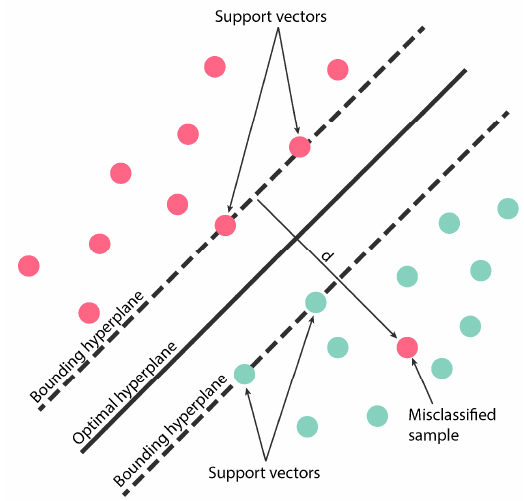
Figure 2. The support vector machines (SVM) method: the optimal hyperplane separates the two classes and is parallel to the bounding hyperplanes on which the support vectors lie. The distance between these two bounding hyperplanes is called the margin, and the distance d between the bounding hyperplane and the outlier (misclassified sample) indicates that there are slack variables (modified from [8]).